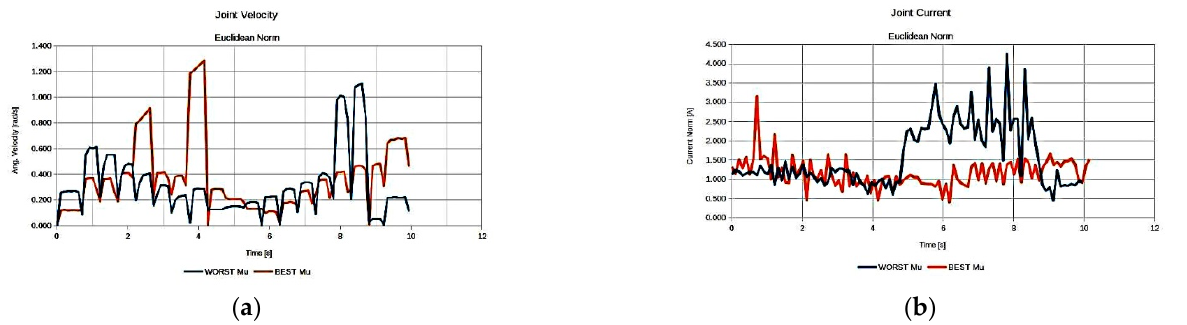
Figure 26. Comparison of the required joint velocities ( a ) and joint current usage ( b ) for the best anatomy and the worst performing anatomy under the Effective Mass performance index for Task